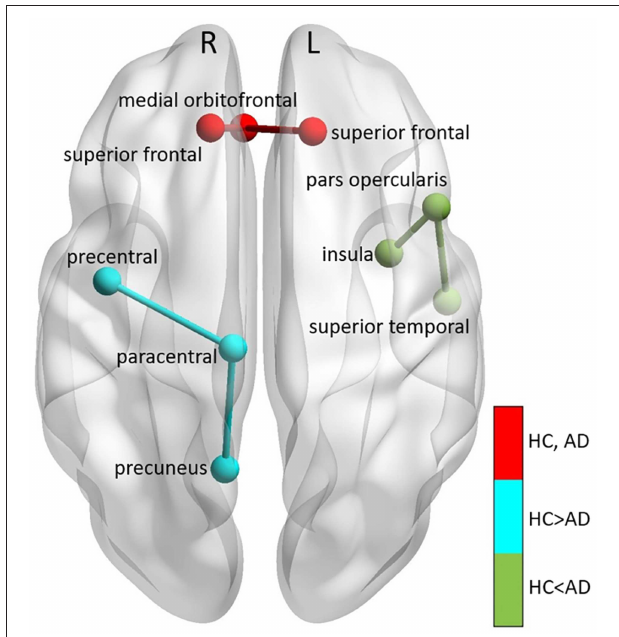
FIGURE 9 | Main PAC paths in HC and AD. Three main paths were found: (1) right superior frontal-right medial or bitofrontal-left superior frontal corresponding to the strongest PAC in HC, remaining also the strongest in AD (colored in red), (2) left insula-left pars opercularis-left superior temporal, the path that decreased the most in AD compared to HC (colored in cyan), and (3) right precentral-right paracentral-right precuneus , which increased the most in AD compared to HC (colored in green). “L” and “R” denote left and right hemispheres, respectively.